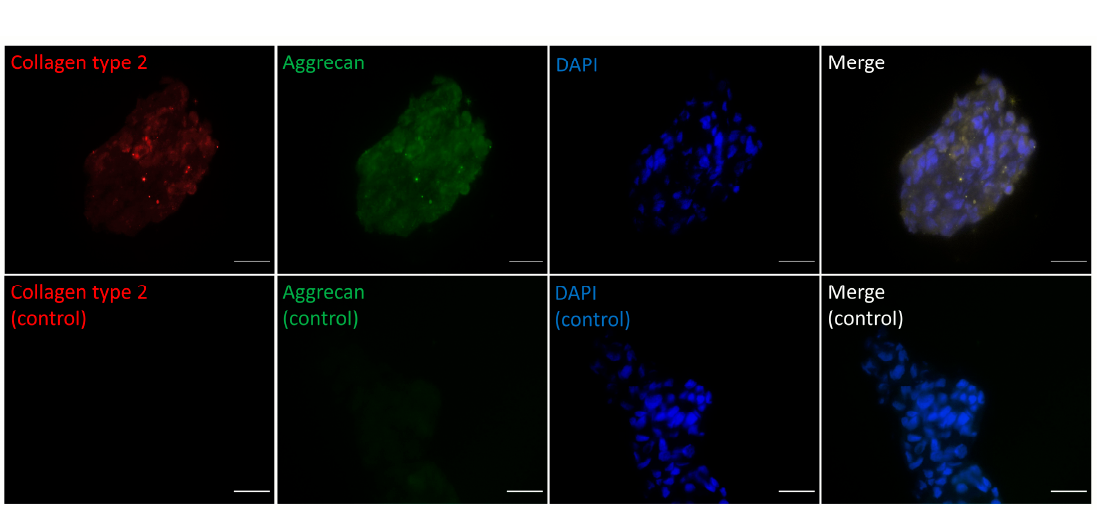
Figure 5. Fluorescent microscopy images of NPC spheroid extracellular matrix (ECM) stained for immune-histology: Collagen type 2 (red), aggrecan (ACAN) (green), and 4 ′ ,6-diamidino-2-phenylindole (DAPI) (blue). Merge represents the color merge of red, green, and blue channels. Control represents the absence of primary antibody and secondary antibody control with DAPI (blue). Scale bar = 50 µm.